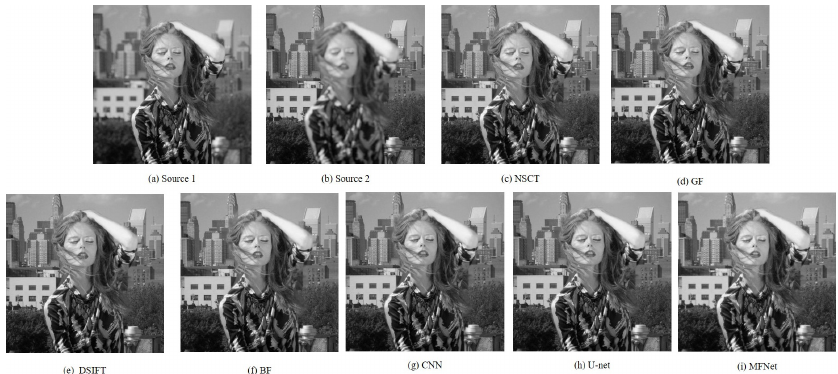
Figure 7. The “Model Girl” source image pair and their fused images obtained with different fusion methods.